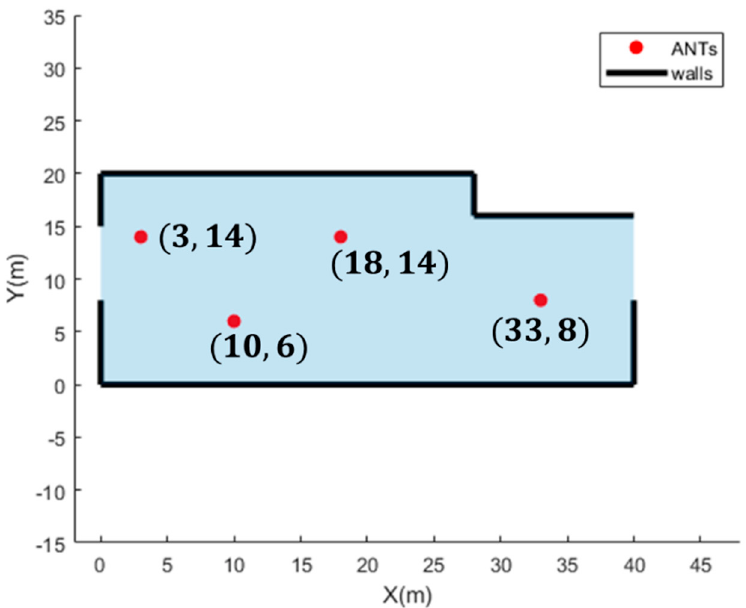
Figure 3. Simulation scenario. Dark area is the simulation area.